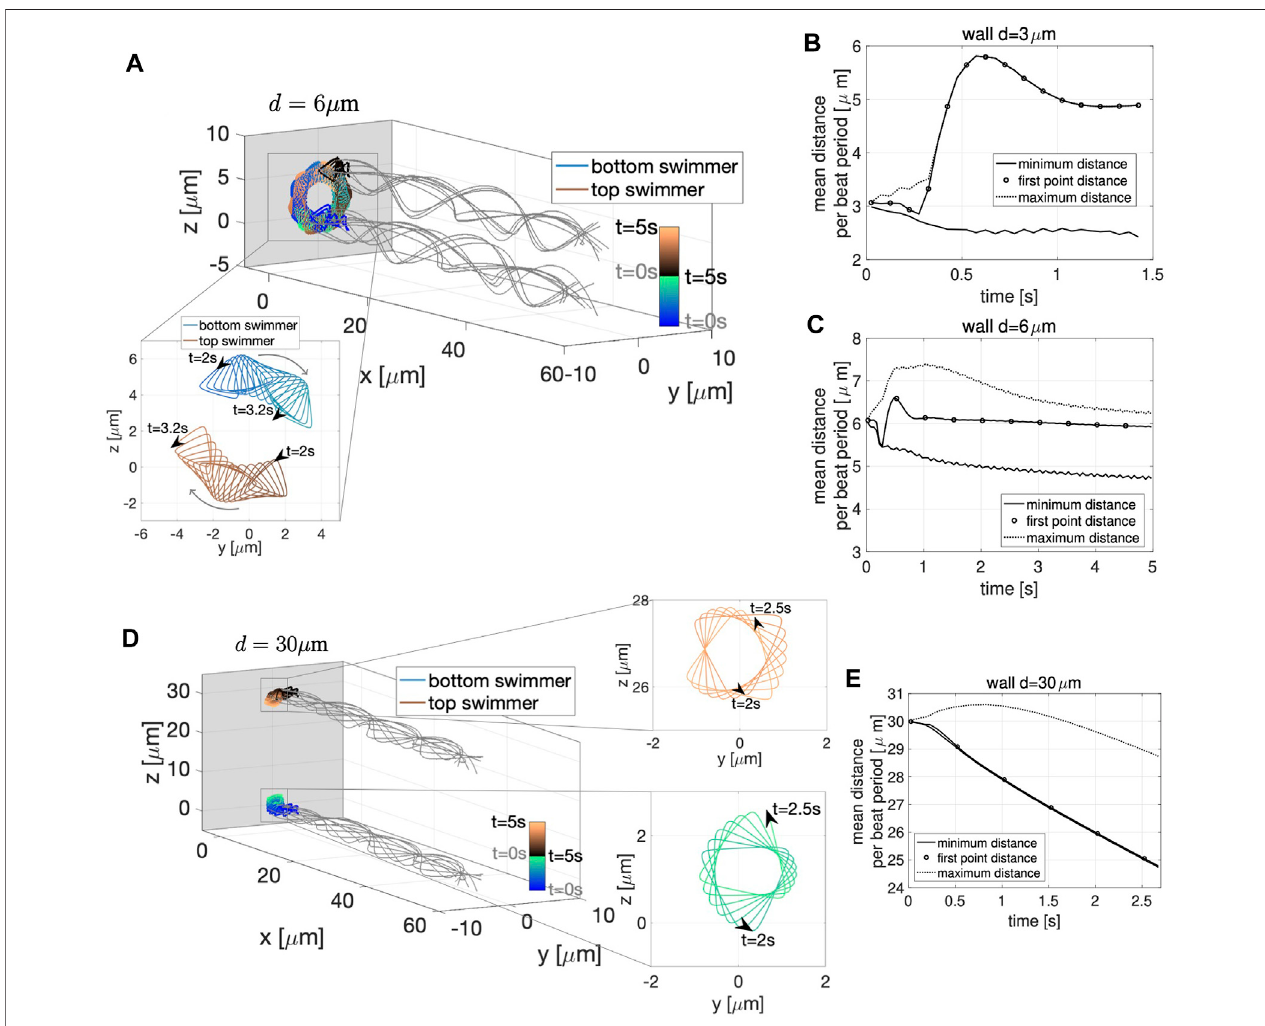
FIGURE10| Quasi-PlanarSwimmersNearaWall.3D fl agellarcon fi gurationsforthe fi rstbeatperiod(graylines)andthetrajectoryofthe fi rstpointinthedirectionof swimming(coloredlineswithrespecttotime)overthetimeintervalfrom0to5 sforthetwoswimmers,initializedatadistance d (cid:1) 6 μ min (A) and d (cid:1) 30 μ min (D) neara wall at x (cid:1) − 5 μ m. The curves traced by the fi rst point of the two swimmers on the yz -plane over the speci fi ed time interval are shown in the corresponding zoomed-in portions. Minimum (solid line) and maximum (dotted line) distance between the two swimmers and distance between the fi rst points of the two swimmers (circles) with respect to time for initial distance d (cid:1) 3 μ m in (B) , d (cid:1) 6 μ m in (C) , and d (cid:1) 30 μ m in (E) (distances averaged over a beat period). The gray panel in (A , D) represents the